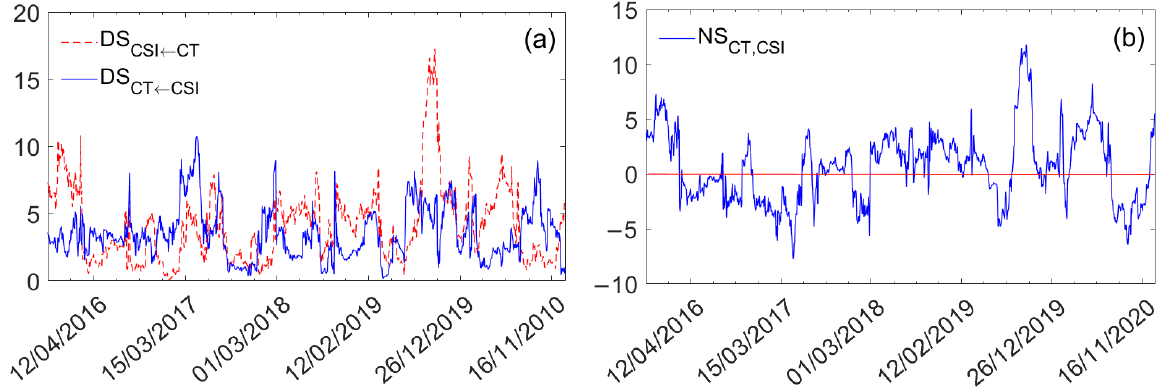
Figure 2. Dynamic evolution of the volatility spillover index between the carbon (CT) and overall stock (CSI) markets: ( a ) shows the directional volatility spillover index between CT and CSI, and ( b ) presents the net volatility spillover index between CT and CSI.